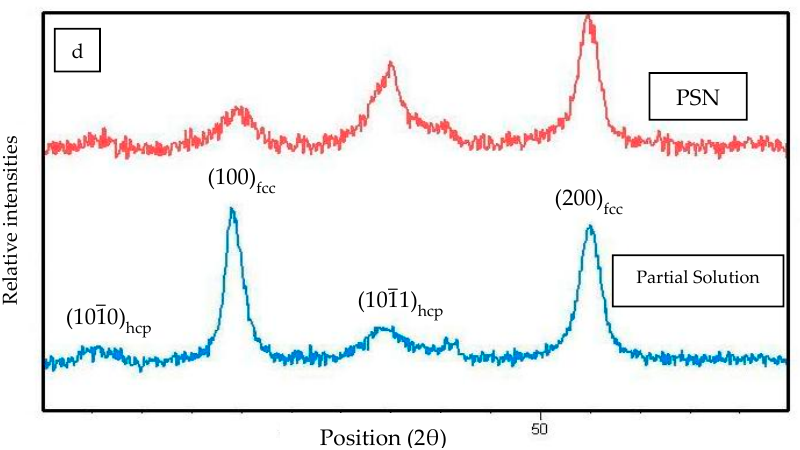
Figure 3. ( a , b ) Particle-stimulated nucleation of recrystallization at carbides. ( c ) Recrystallization originates from the deformation zone near the carbides. ( d ) XRD graphs of the partial solution and particle-stimulated nucleation (PSN) specimens.